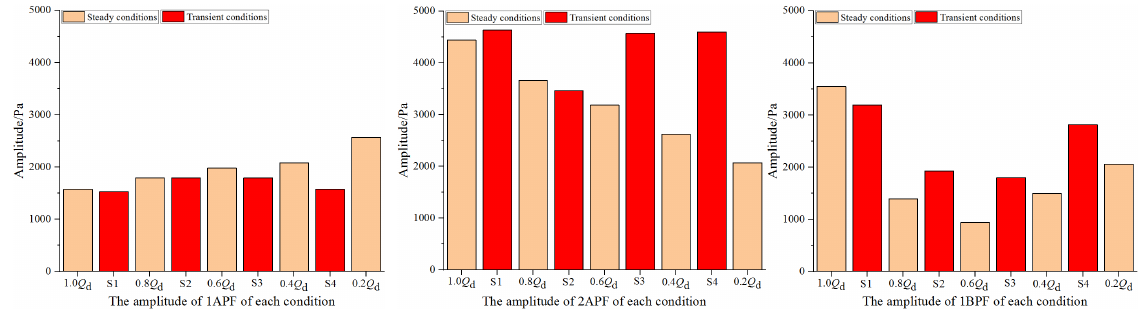
Figure 8. The amplitude of the main characteristic frequencies of dynamic pressure at P1.